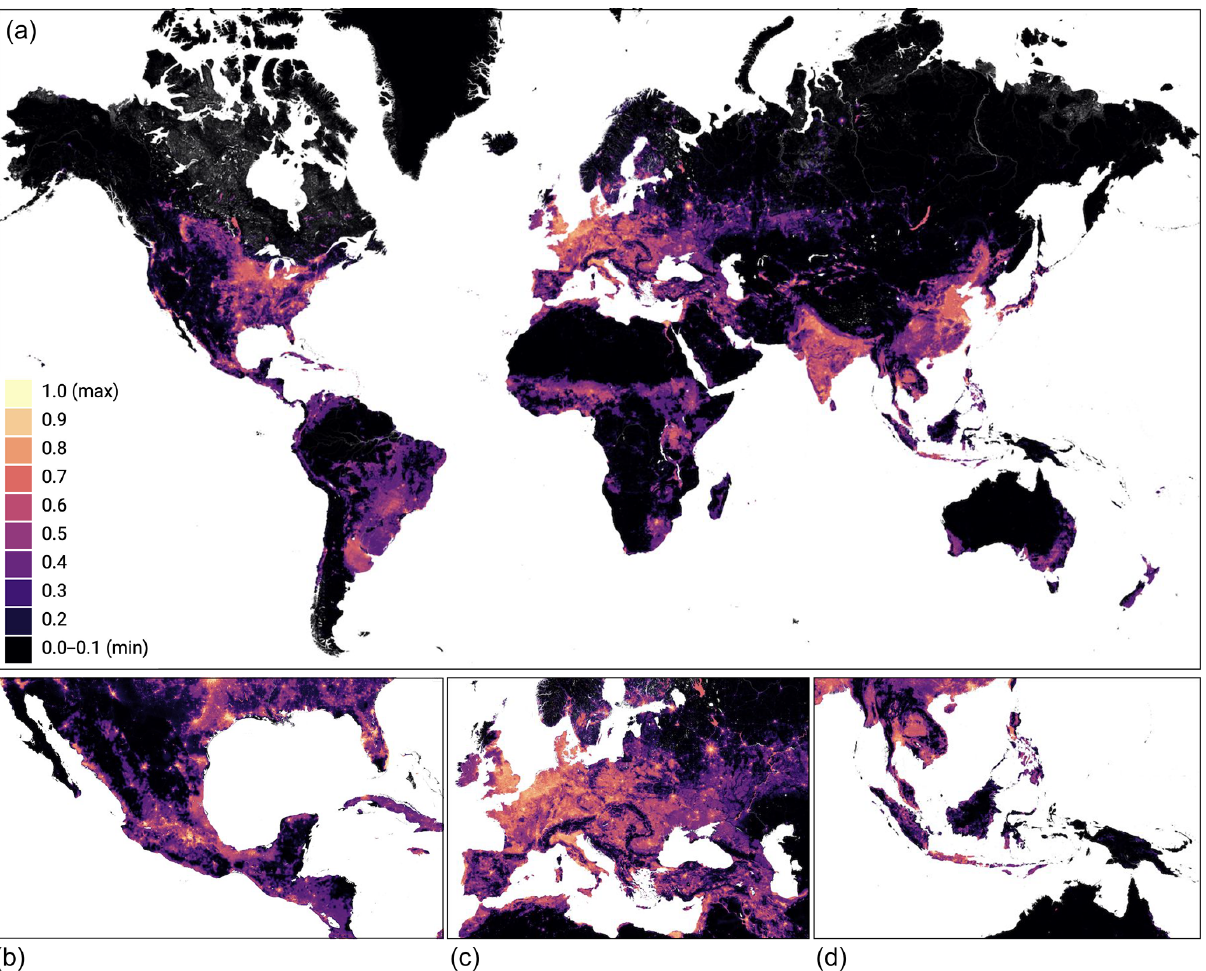
Figure 3. The degree of human modification for circa ∼ 2017: (a) globally; (b) in central America; (c) in Europe, and (d) in Oceania. Note that interactive maps are available at https://davidtheobald8.users.earthengine.app/view/global-human-modification-change (last